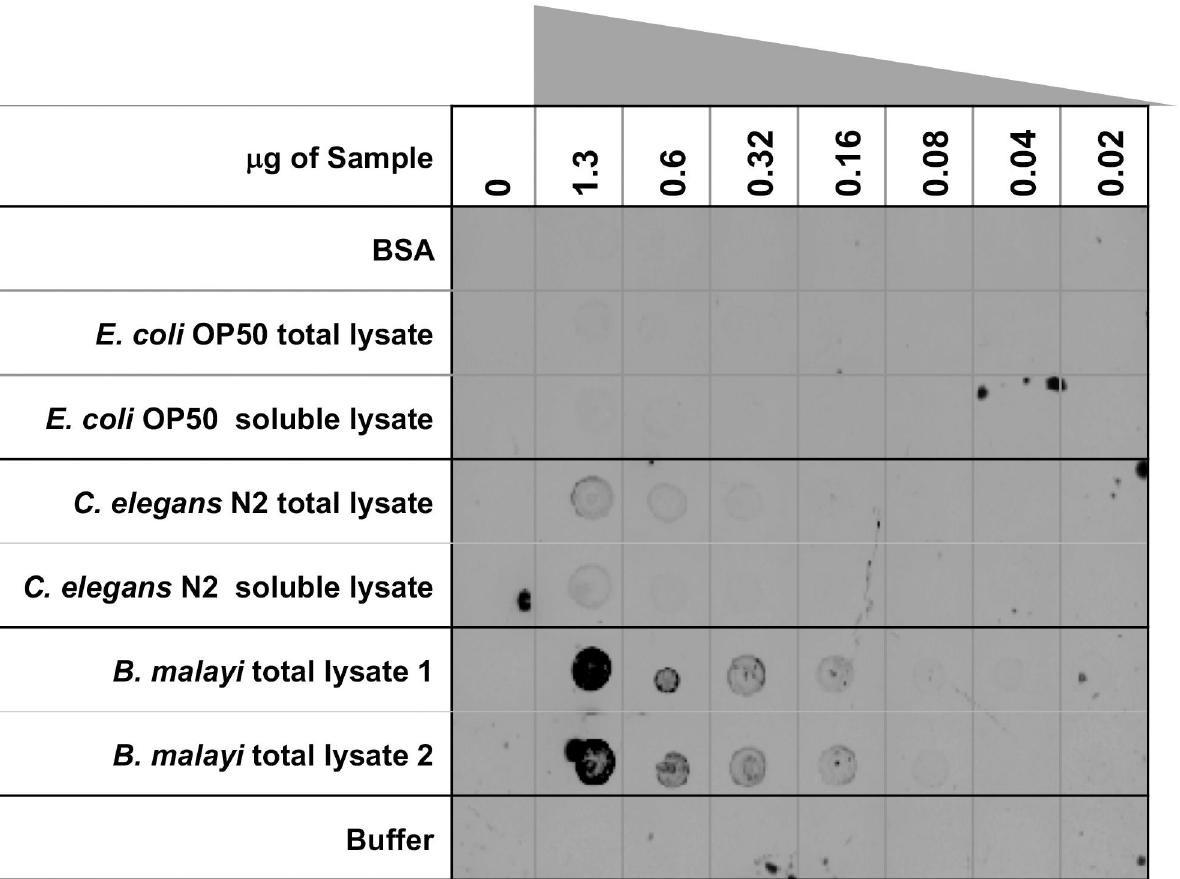
Fig 2. FLAER Dot Blot. B . malayi and C . elegans lysates react with FLAER in a concentration dependent manner. Samples: BSA, E . coli OP50 total and soluble lysate, C . elegans N2 total and soluble lysate, B . malayi total lysate 1: B . malayi total lysate untreated, B . malayi total lysate 2: B . malayi surface PI-PLC treated total lysate. After 1:1 series dilution, samples were spotted on to a nitrocellulose membrane and incubated overnight with FLAER reagent.